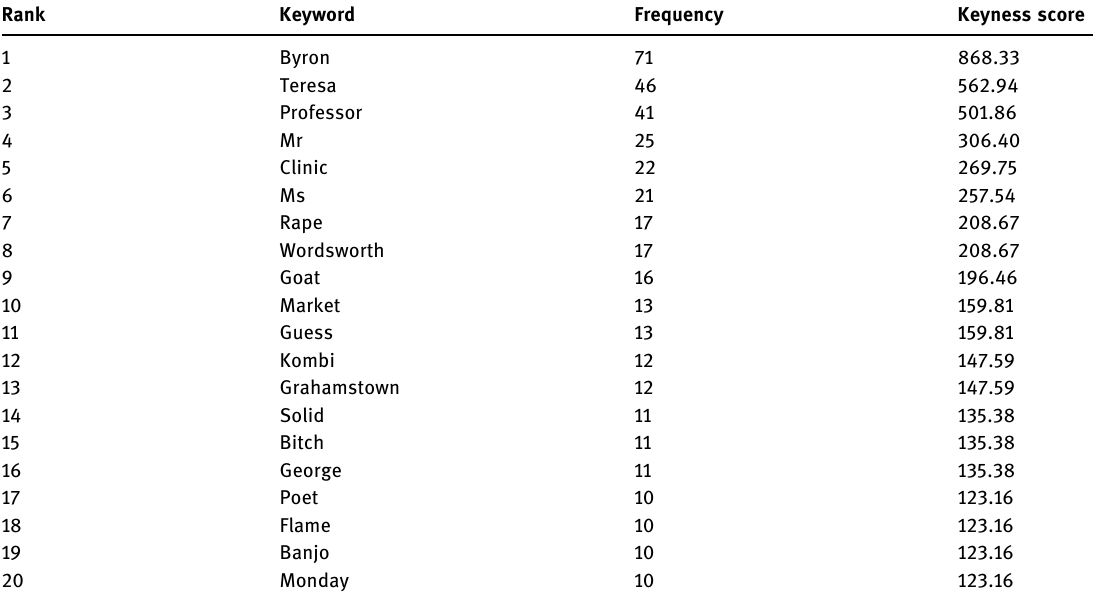
Table 2: Top 20 keywords in DS ( characters ’ names excluded )